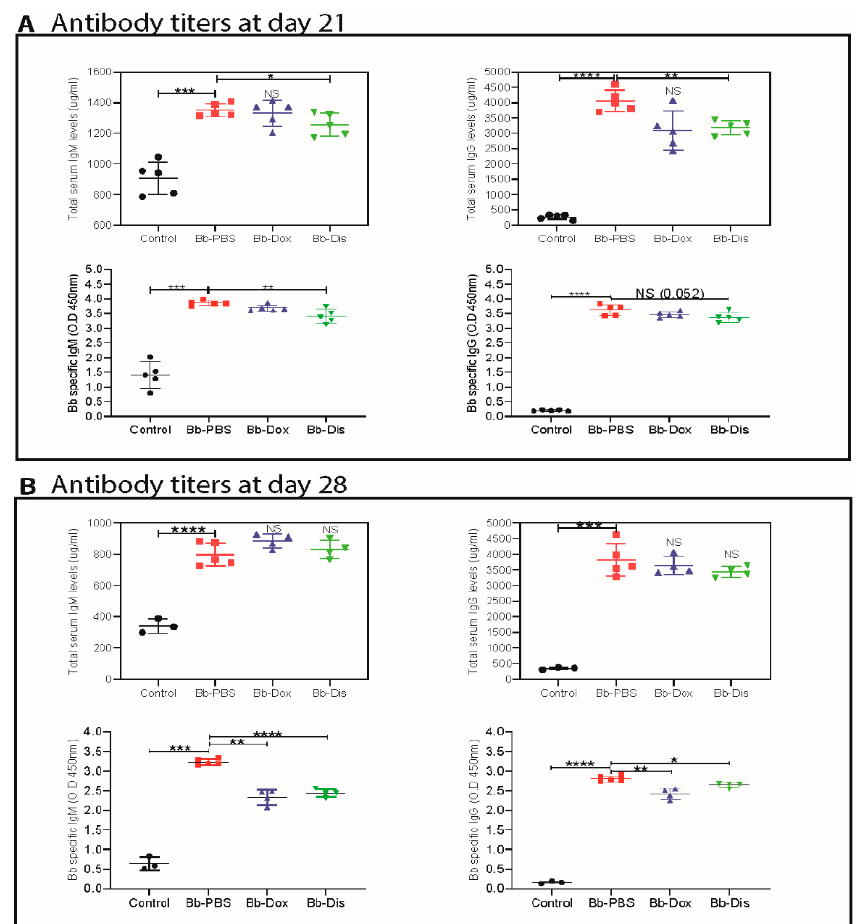
Figure 5. Antibody response in the serum with and without antibiotics treatment which were quantified by ELISA. Total and Bb specific concentration of IgM, IgG, antibodies ( A ) day 21 post- and ( B ) day 28 post-infection. Statistics: unpaired t-test with Welch’s correction between controls versus infected and between drug-treated group versus infected group. * p < 0.05, ** p < 0.01, *** p < 0.001, **** p < 0.0001. NS means not significant.